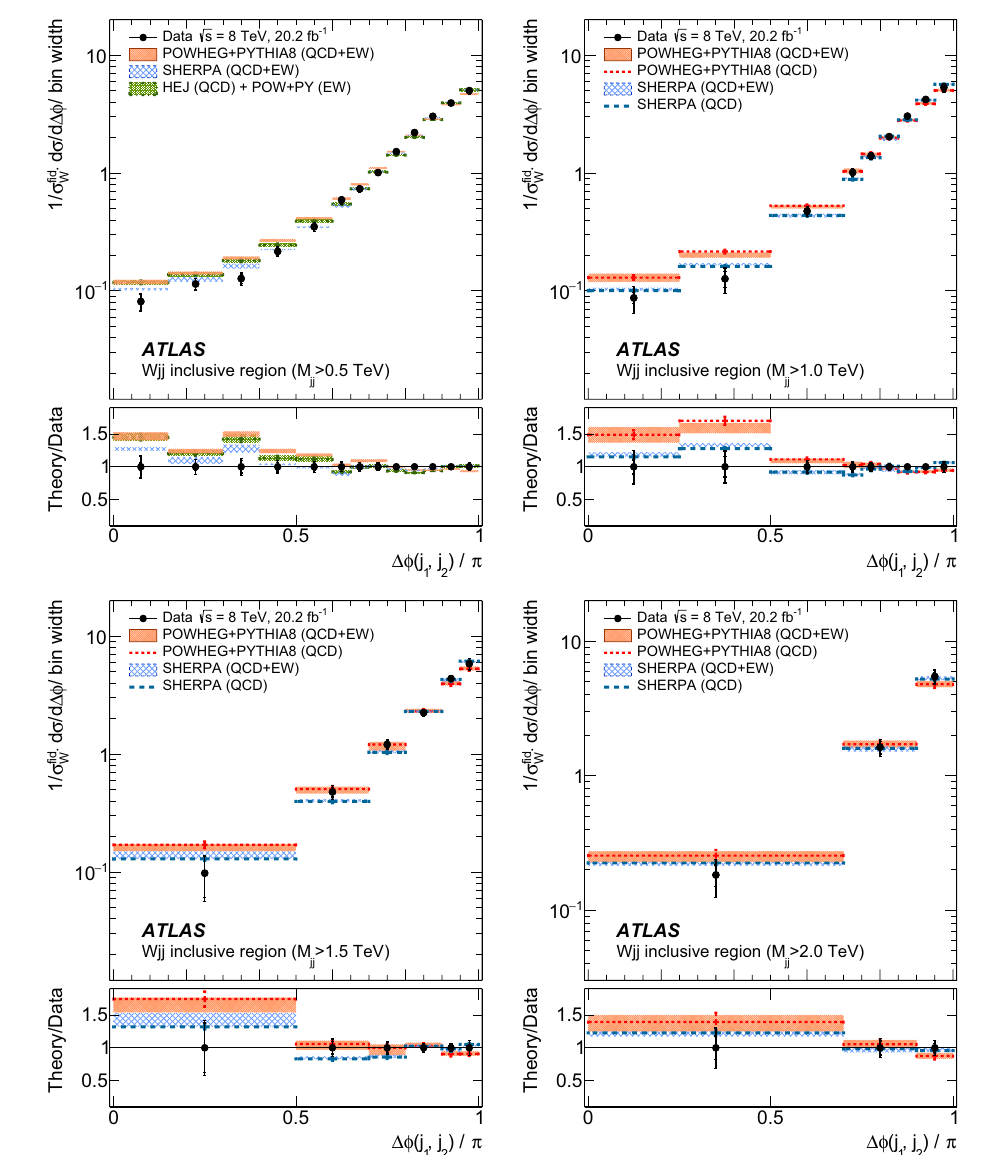
Fig. 48 Unfolded normalized differential W jj production cross sec- tions as a function of (cid:6)φ( j 1 , j 2 ) in the inclusive fiducial region with four thresholds on the dijet invariant mass (0.5, 1.0, 1.5, and 2.0 TeV).